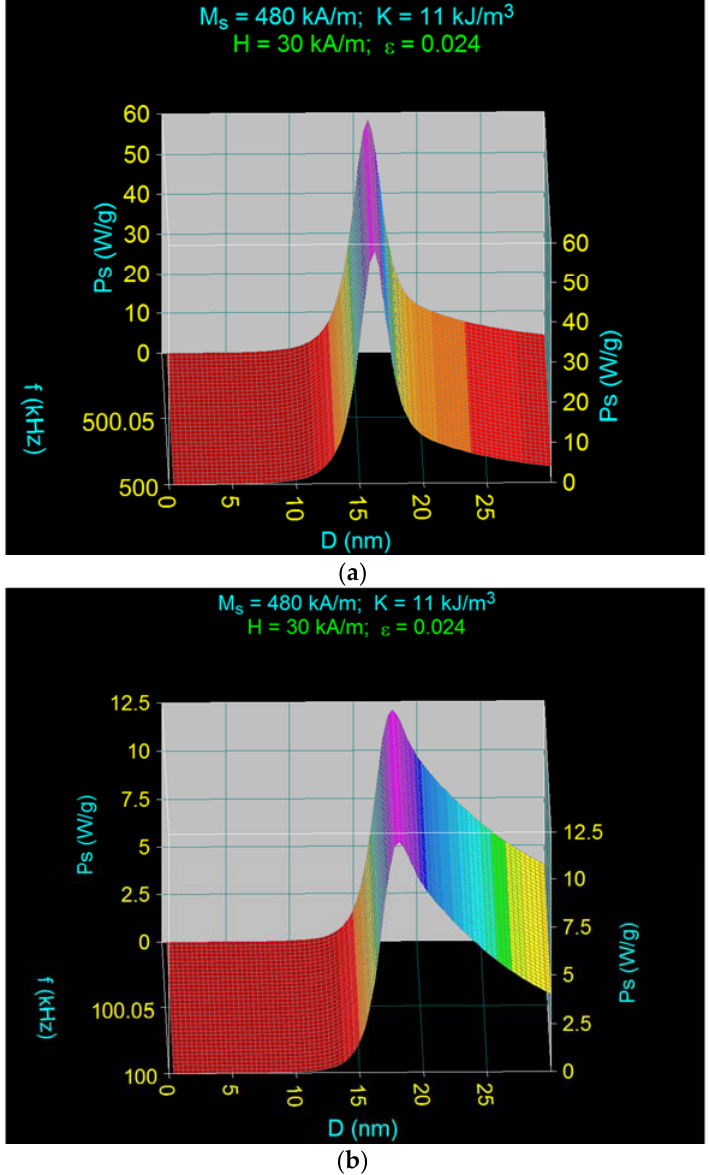
Figure 7. The contribution of the Néel and Brown relaxation processes to the maximum specific loss power in the case of dispersed Fe 3 O 4 – γ -CDs bionanoparticles for ( a ) 500 kHz, and ( b ) 100 kHz. The maximum specific loss powers determined at both the frequency of 500 kHz and 100 kHz (Figure 5) for the values of the magnetic field in the range of 10–50 kA/m, are shown in Figure 8. The results show that the maximum specific loss power increases almost linearly with the amplitude of the magnetic field, the slope being significantly higher at the frequency of 500 kHz. At the same time, the maximum specific loss power at 500 kHz is narrow, being determined by the Néel relaxation processes, and increases quite rapidly with the amplitude of the magnetic field. However, the maximum specific loss power at 100 kHz is wide, being determined by both Néel and Brown relaxation processes, and increases slowly with the amplitude of the magnetic field.